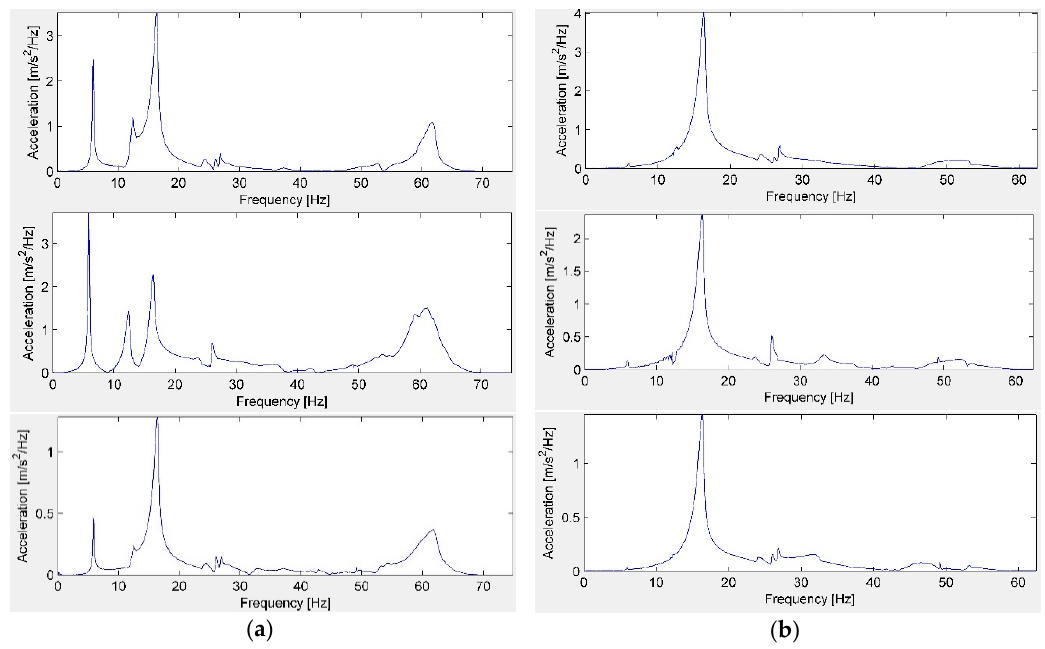
Figure 6. The acceleration in the frequency domain read from the 4th node at directions x (upper), y (central) and z (lower) for striking direction at azimuth: ( a ) 120 degrees and ( b ) 330 degrees.